Question: What visual encoding does this figure use to show its data?
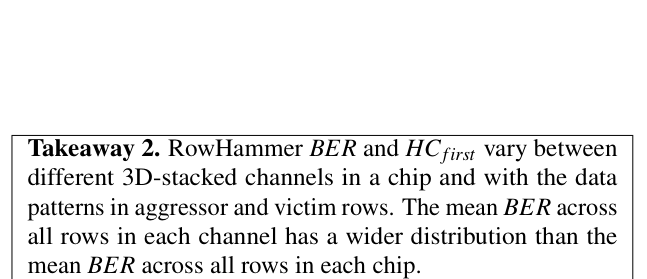
Answer: line